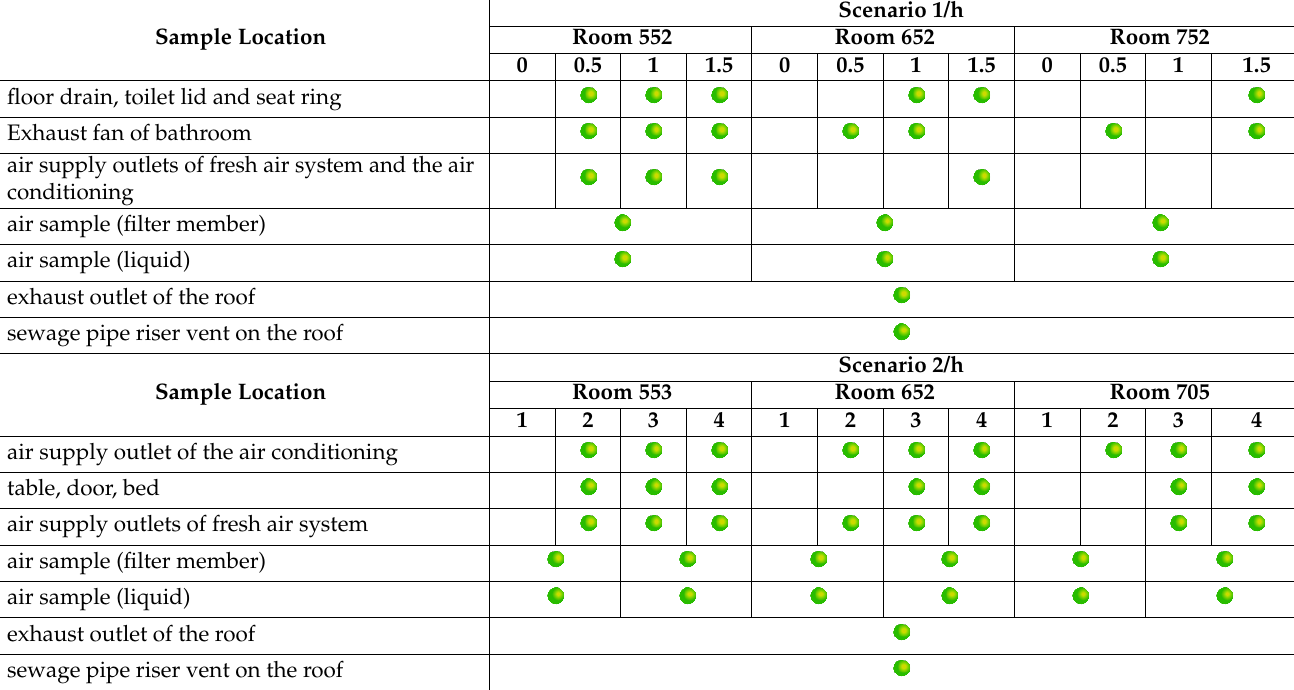
Table 1. The detection results of fluorescent microspheres of swab samples and air samples collected in different locations of different rooms in different time.